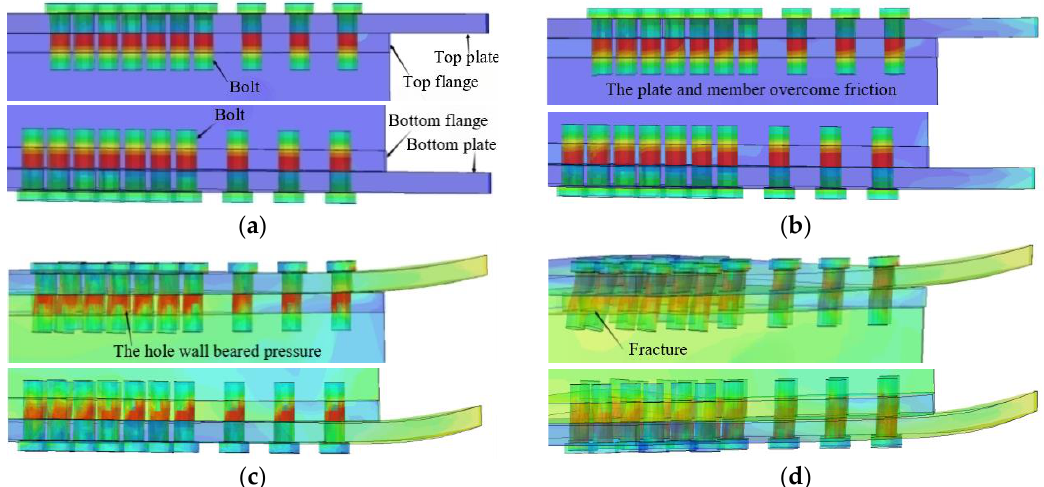
Figure 11. Deformation process of AAG joints. ( a ) Initial phase; ( b ) friction-resistance phase; ( c ) hole wall bearing phase; ( d ) failure phase.